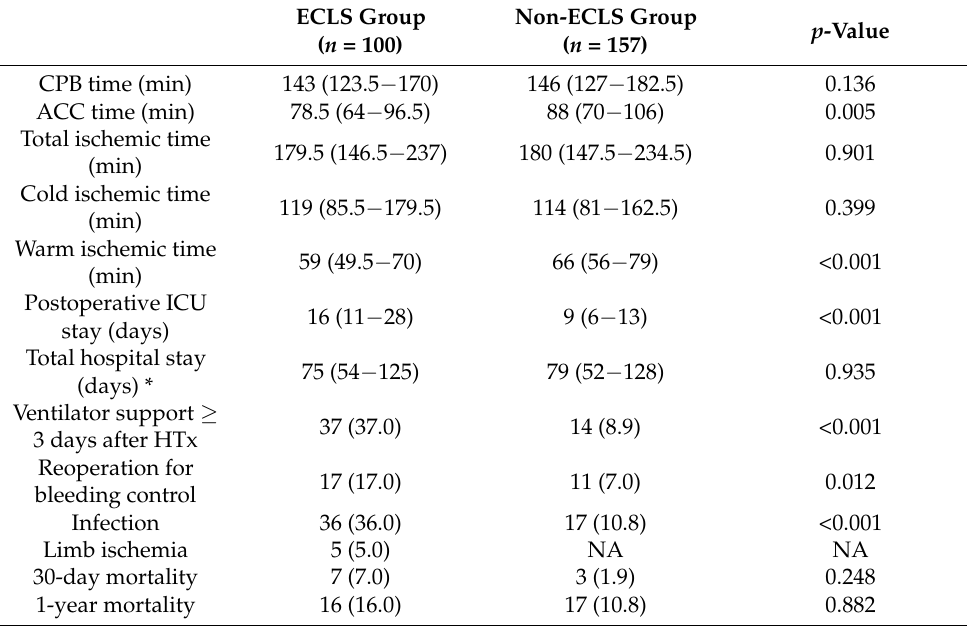
Table 2. Operative and postoperative characteristics of all